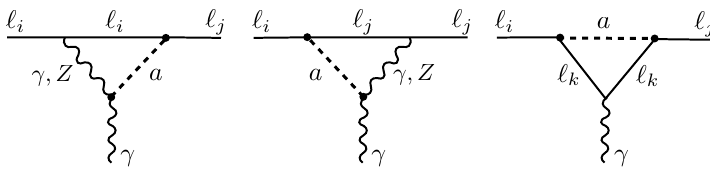
Figure 33 . Diagrams contributing to LFV electromagnetic form